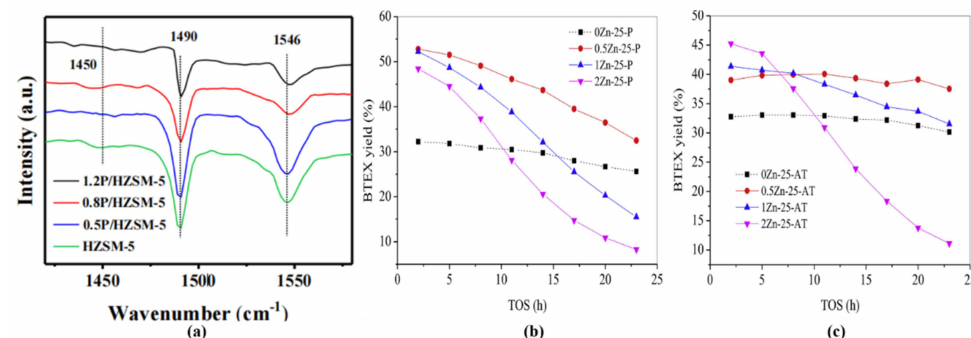
Figure 15. ( a ) FT-IR spectra of HZSM-5 with different phosphorus loadings with pyridine (Py) adsorption at 300 ◦ C. Reprinted with permission from Dai et al. [95]. Copyright (2020) American Chemical Society. ( b ) BTEX yield with TOS of Zn-doped ZSM-5(25)-P and ( c ) Zn-doped ZSM-5(25)-AT. The Zn doping level represents the mass ratio of Zn/Fe, including 0.5%, 1%, and 2%; P—parents; AT—Alkali treatment. Reprinted with permission from Zhang et al. [136]. Copyright (2019)